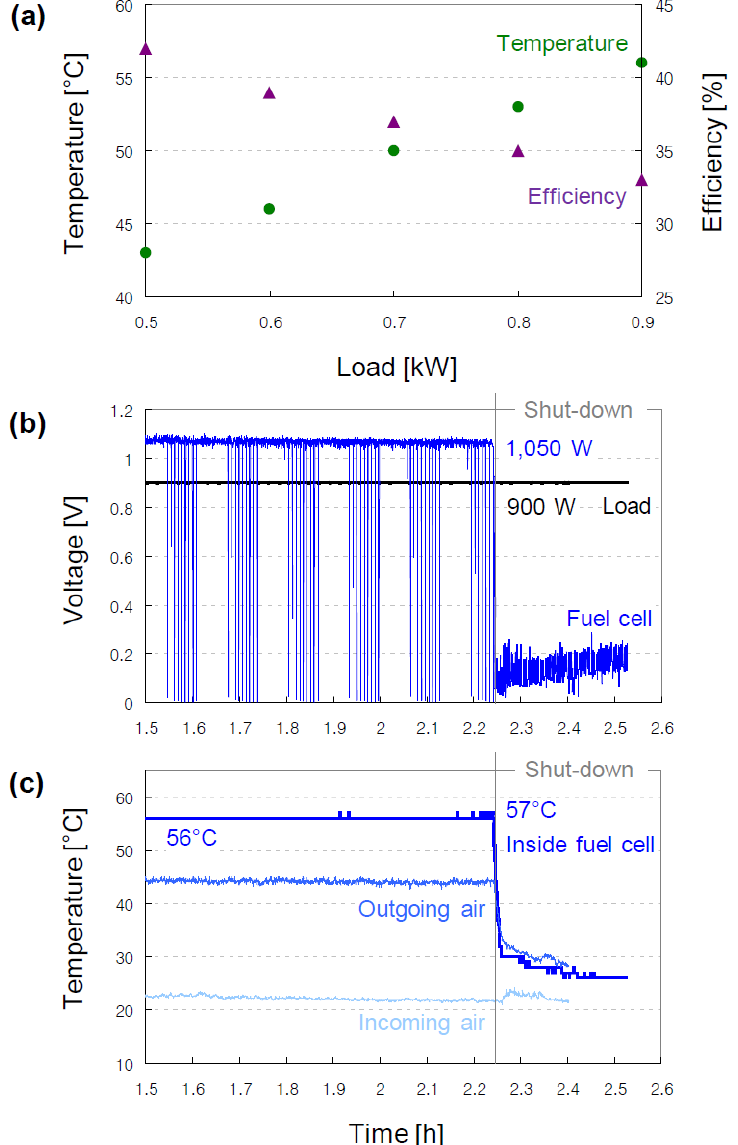
Figure 1. Results of unit tests performed to determine the maximum output power that the fuel cell can sustain for 24 h. ( a ) Temperature and efficiency versus power, ( b ) Voltage, and ( c ) Temperature versus time. The voltage drops observed in the fuel cell are caused by short-circuiting with the SCU. The voltage drops occurred regularly but appear irregular due to the infrequent measurements at intervals of 1 s.